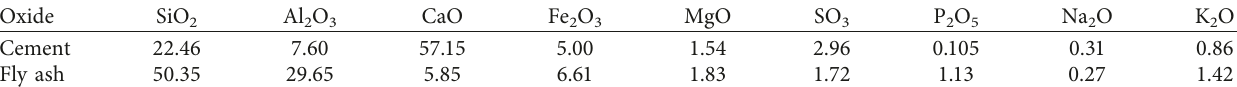
Table 1: Chemical composition of cement and fly ash.